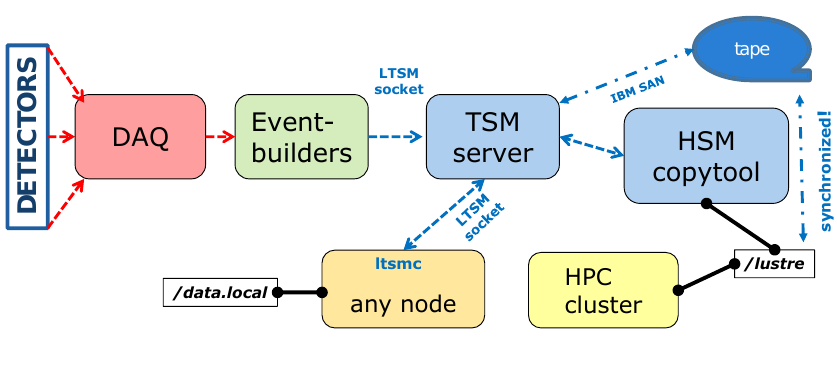
Figure 2. Components of the LTSM system: The DAQ event builders send data via LTSM socket API connections directly to the TSM server archive that is linked to a tape robot device using IBM SAN (Storage Area Network) . The HSM copytool provides the file synchronization between the TSM archive and the lustre file system of the HPC cluster. Additionally, an external user can access files via socket from TSM archive using the ltsmc commmand line